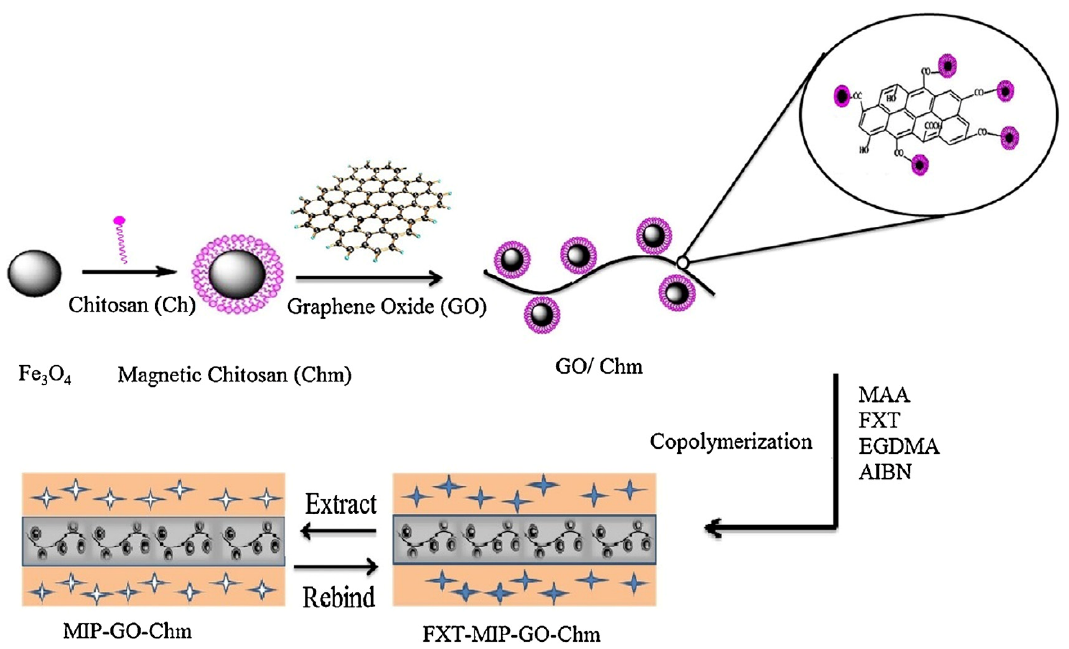
Figure 3. Preparation of magnetic chitosan/graphene oxide. Reproduced from the work in [50] with permission from Elsevier.